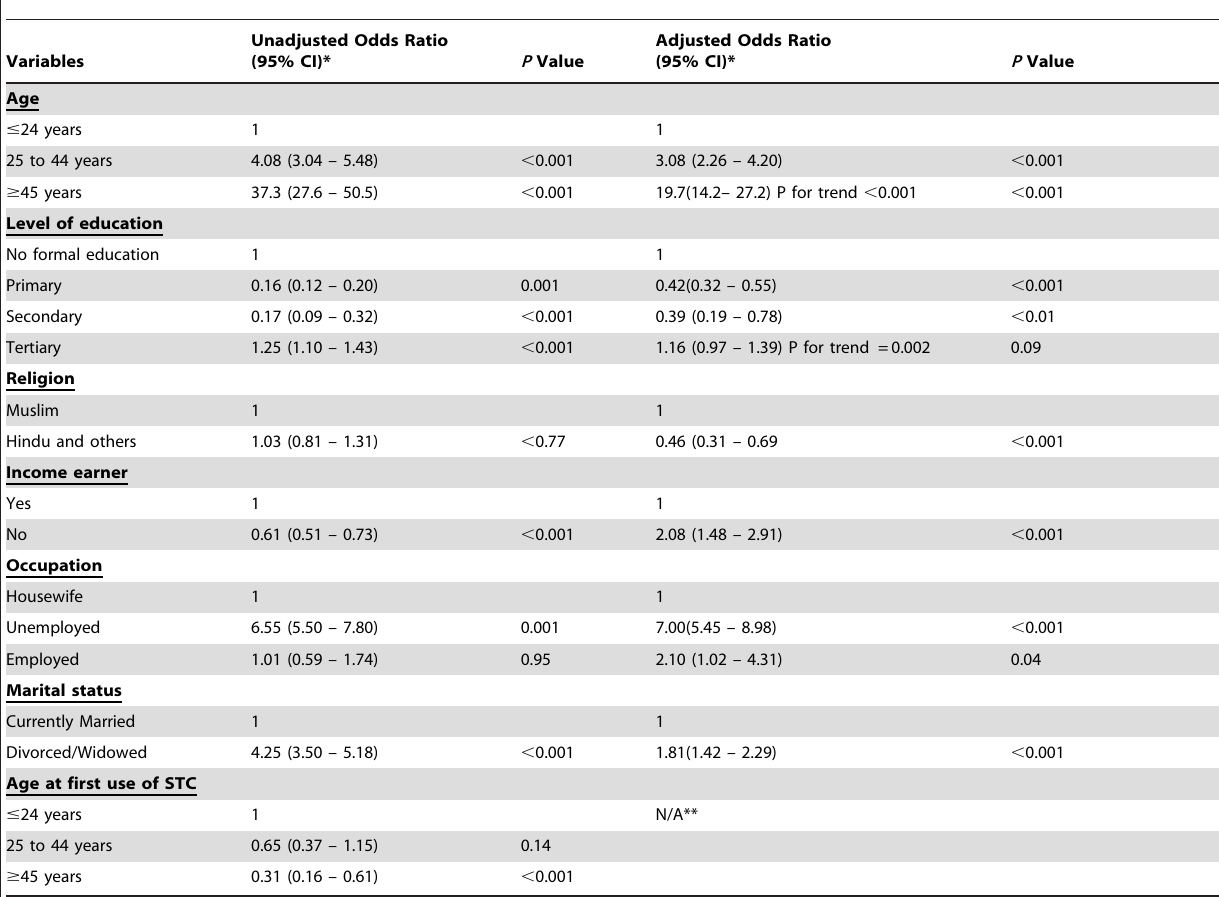
Table 2. Unadjusted and adjusted odds of current STC (n=4515).